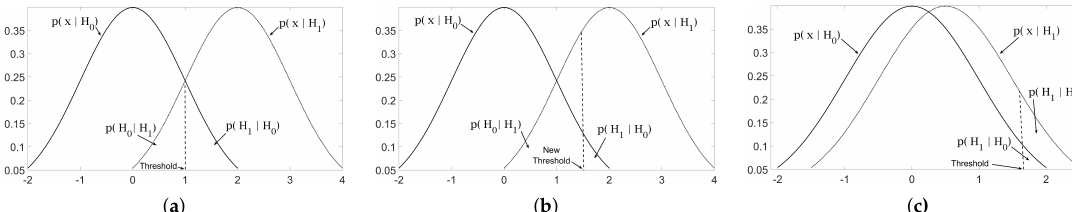
Figure 4. Depiction of a simple detection problem where the probability of null hypothesis p ( x |H 0 ) = N ( 0, σ 2 ) and probability of alternate hypothesis p ( x |H ) = N ( µ , σ 2 ) are plotted together. Here, 1 ( a ) show the relationship between error probability regions p ( H 0 |H 1 ) , p ( H 1 |H 0 ) and the detection probability region p ( H 1 |H 1 ) ; ( b , c ) highlight the trade off between P fa and P d with an increase in threshold value λ